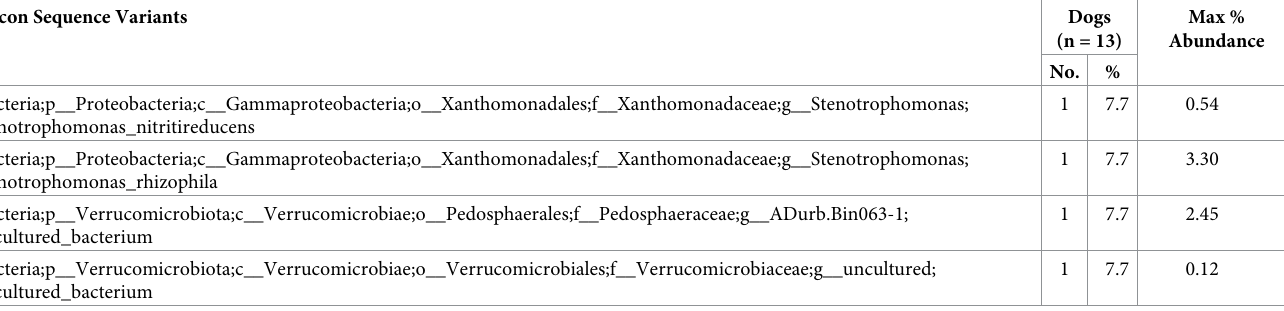
PLOS ONE | https://doi.org/10.1371/journal.pone.0281432 February 10,